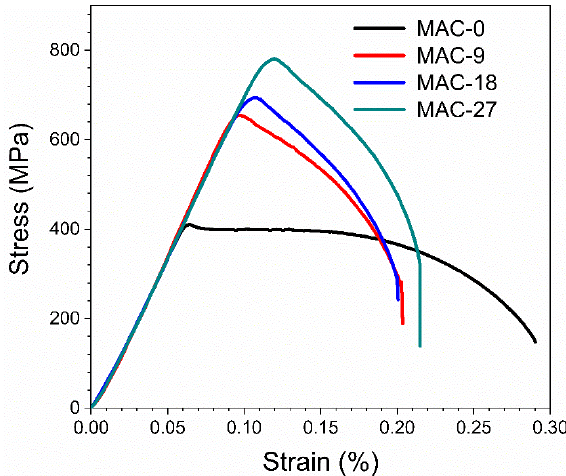
Figure 3. Stress-strain curves.